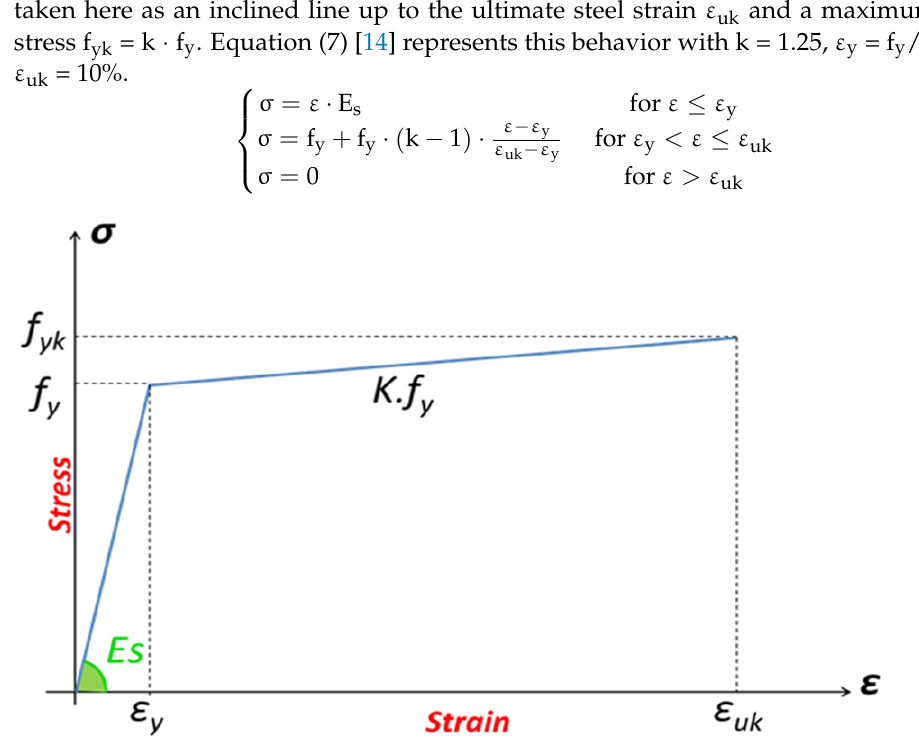
Figure 3. The adopted behavior of Steel Reinforcement [14].